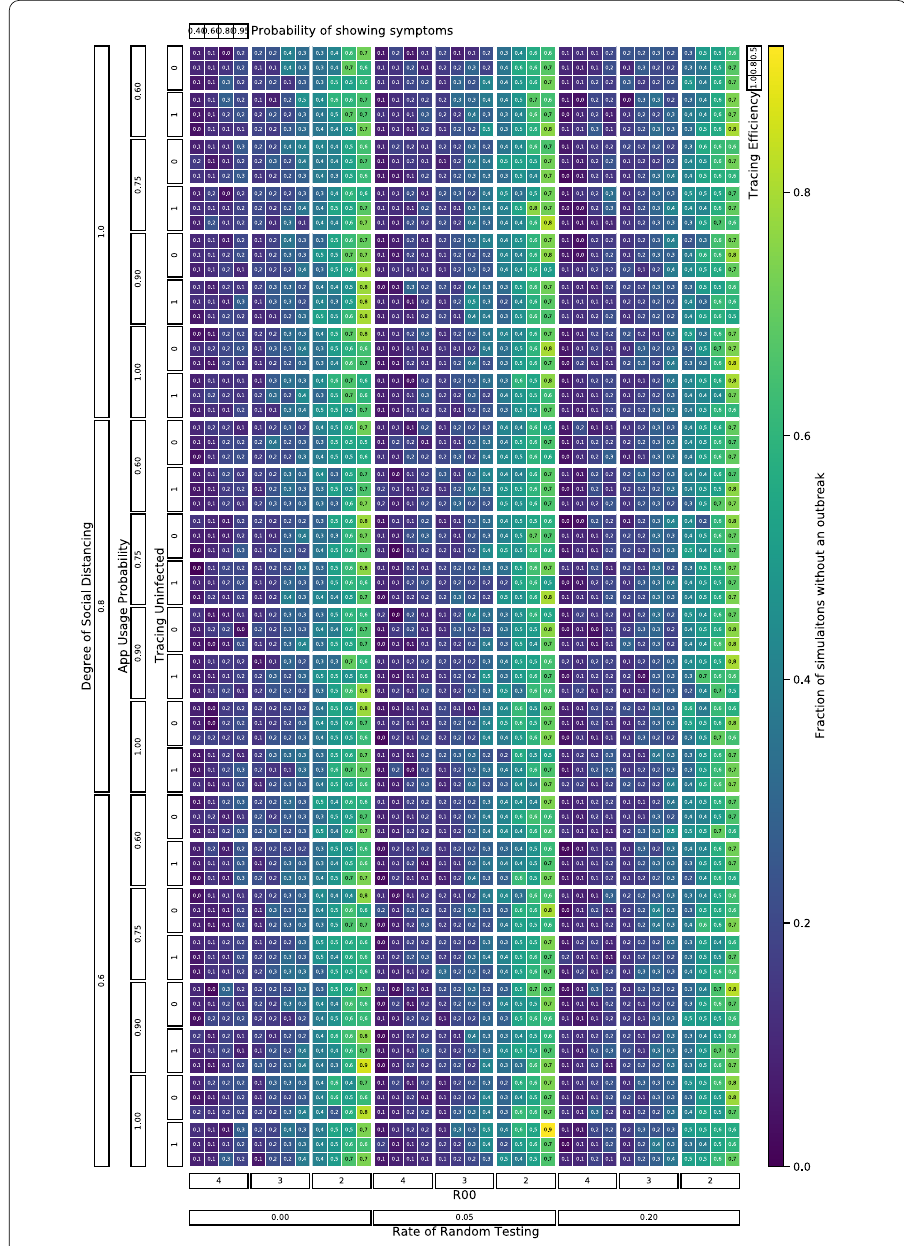
Figure 28 The fraction of MC runs where the outbreak stopped (by chance) before the threshold number of infected people to start interventions was reached